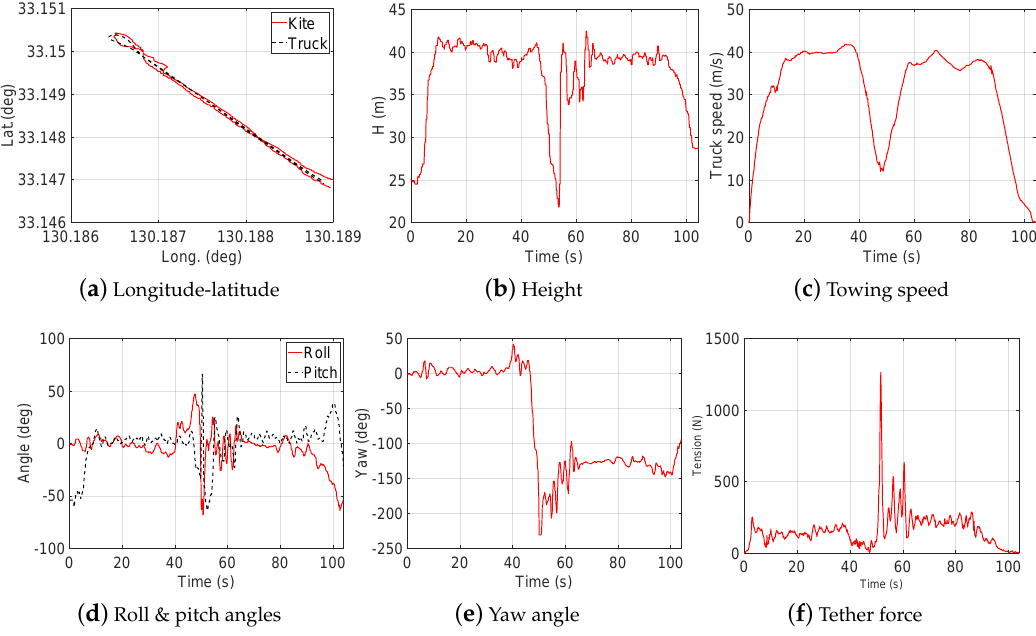
Figure 16. Data for test